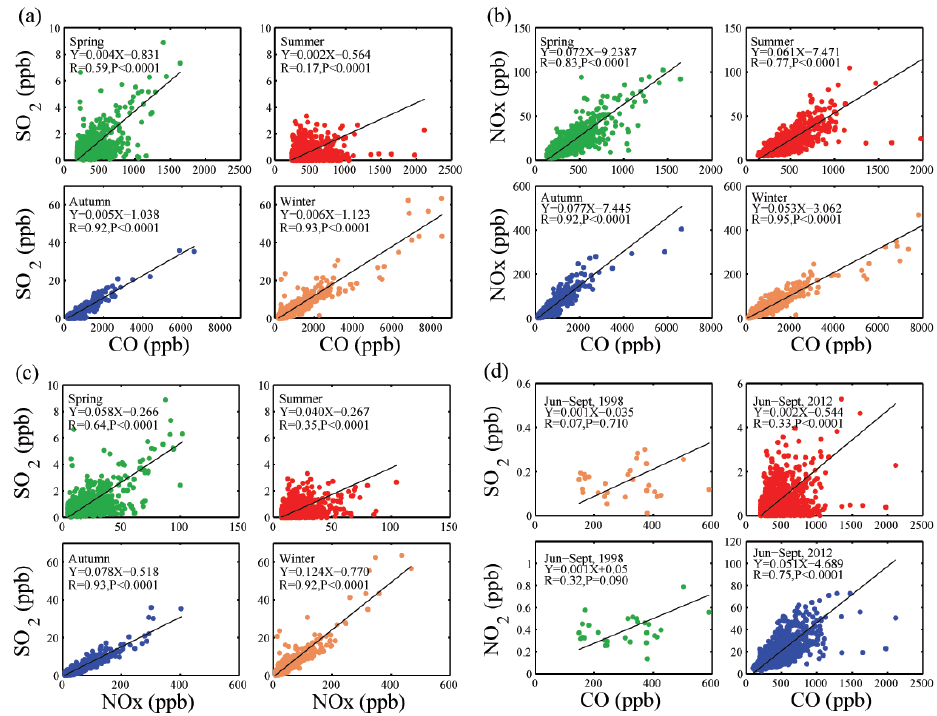
Figure 8. Reduced major axis regression of (a) SO 2 versus CO; (b) NO x versus CO; (c) SO 2 versus NO x in the four seasons during 2012 and 2013 in Lhasa using hourly average data. (d) Reduced major axis regression of SO 2 versus CO and NO 2 versus CO during June and September, respectively, in 1998 and 2012 in Lhasa.